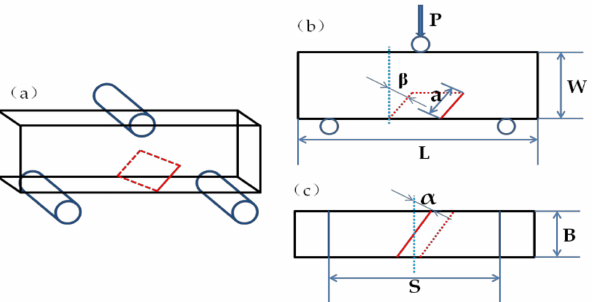
Figure 1. The loading configuration and geometry of the TPB-IC specimen. ( a ) Panorama of specimen loading. ( b ) Front view of specimen loading. ( c ) Bottom view of specimen